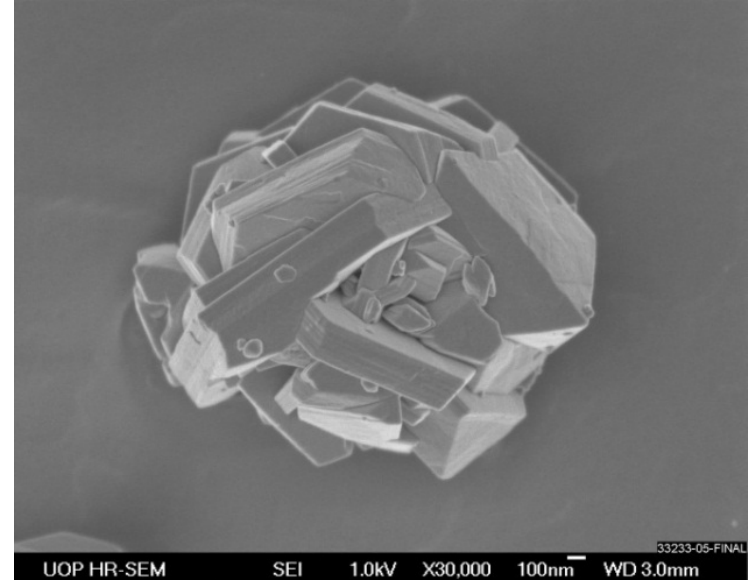
Figure 1. SEM image of a representative particle of FAU/EMT